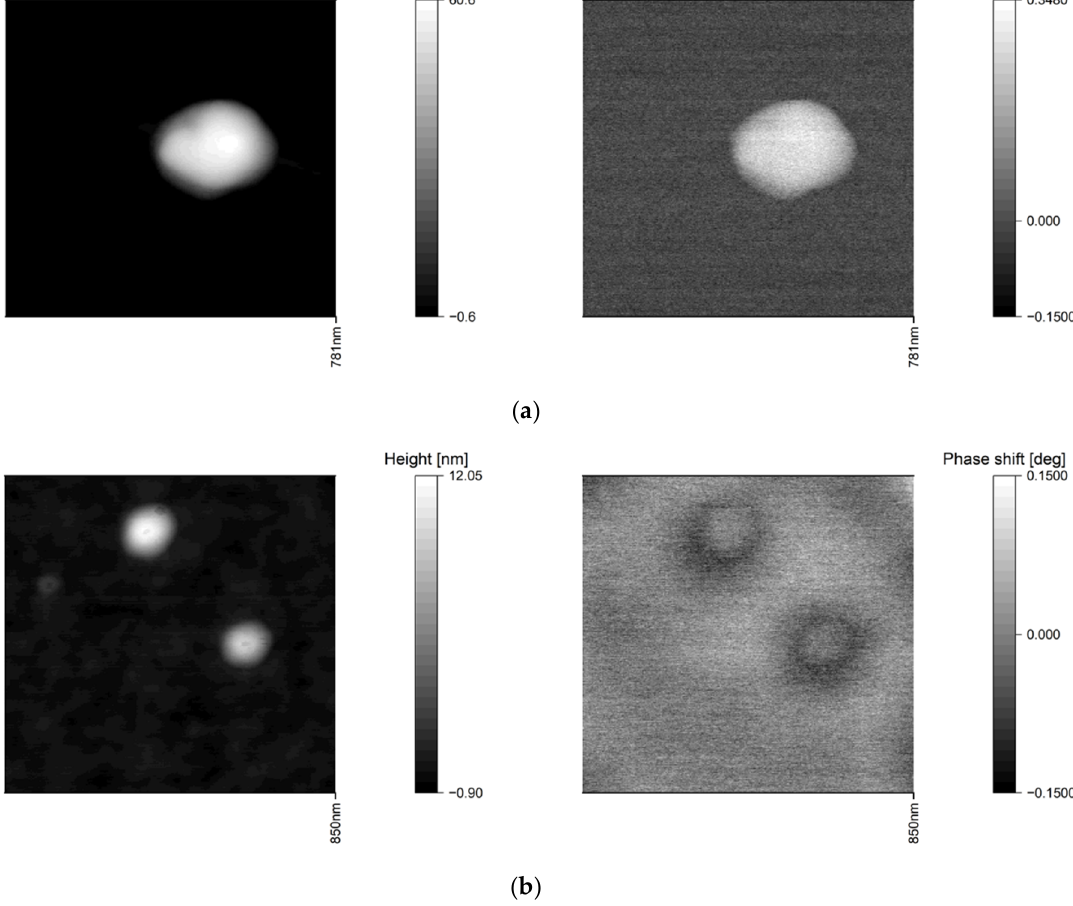
Figure 2. ( a ) Atomic Force Microscopy (AFM) topography (left) and the corresponding phase image in lift mode (right) of a single polystyrene (PS)-nanoparticle with a diameter of 60 nm (silicon substrate; z = 50 nm; r tip = 80 nm). ( b ) AFM topography (left) and the corresponding phase image in lift mode (right) of two single superparamagnetic iron oxide nanoparticles (SPIONs) with a diameter of 12 and 8 nm (silicon substrate; z = 50 nm; r tip = 80 nm).